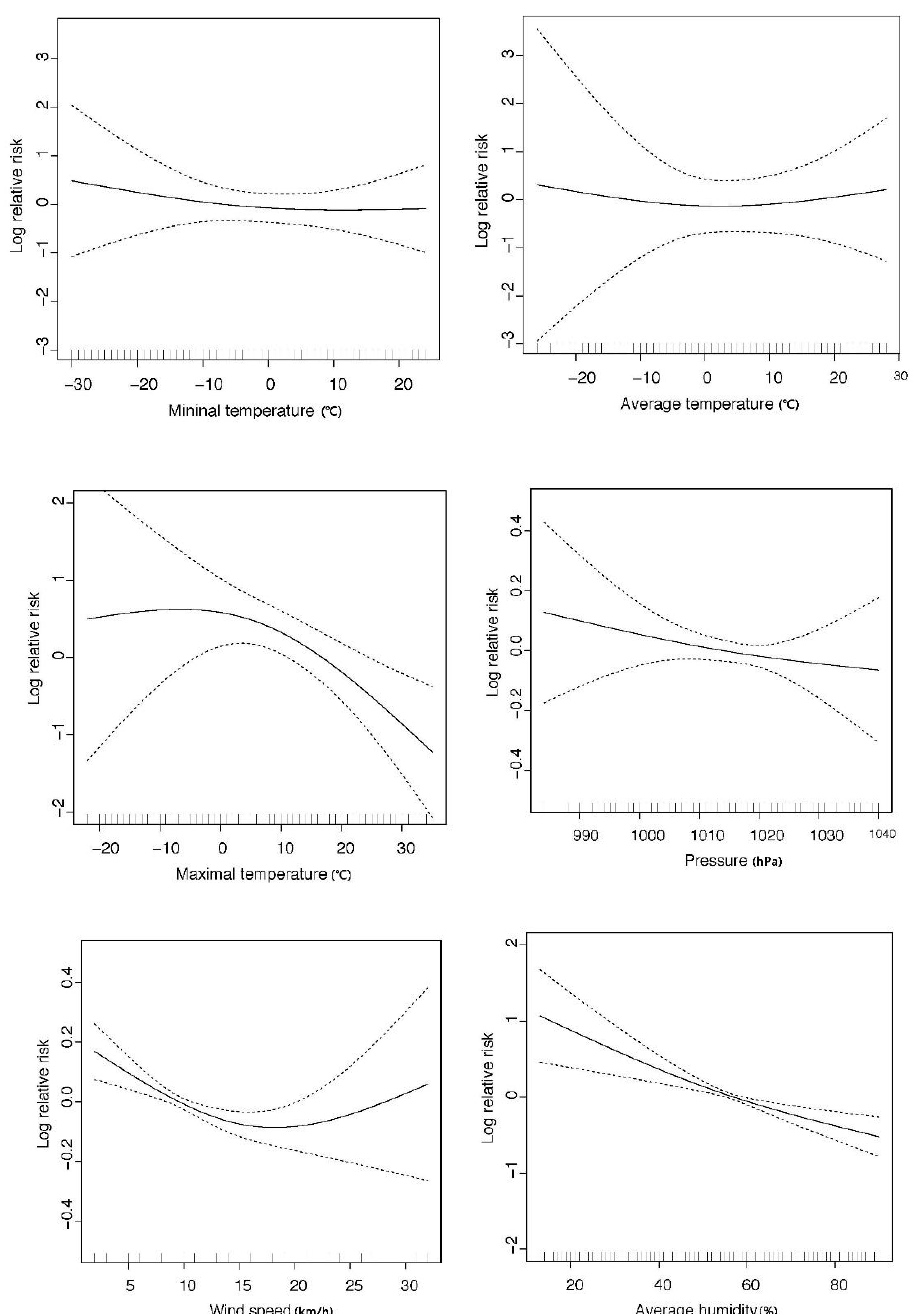
Figure 4. Smoothed plots of exposure-response relations between meteorological factors and outpatient visits for AR in Changchun, China (2012–2015). The solid line presents log relative risk of outpatient visits for AR, while the dashed lines present 95% confidence interval (CI) of the log relative risk. We observed a positive exposure–response relationship between lower wind speeds (<10 km/h) and AR relative risk, which is the result of static wind condition that not suitable for the diffusion of atmospheric